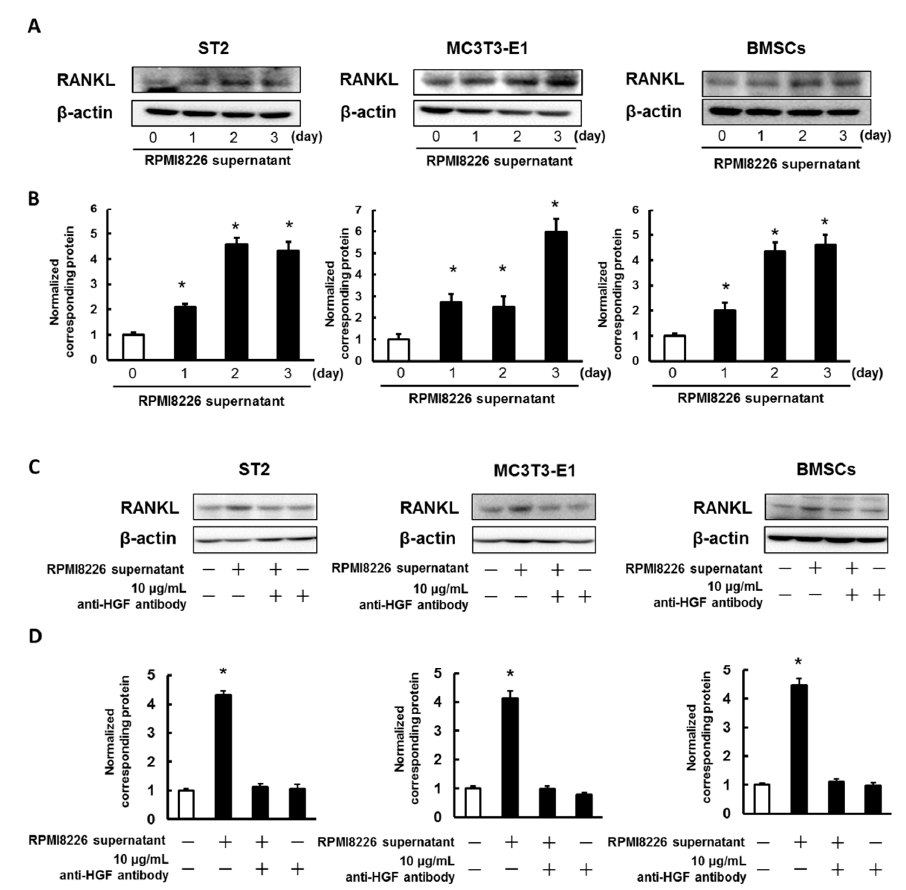
Figure 3. RPMI8226 cell supernatant induces RANKL expression. ( A ) ST2 cells, MC3T3-E1 cells, and mouse BMSCs were incubated with RPMI8226 cell supernatant. At various time points, the cell lysates were analyzed by western blotting using anti-RANKL antibody. ( B ) Quantification of the amount of RANKL, normalized to the amounts of β -actin. The results are representative of five independent experiments. * p < 0.01, compared to controls (one-way ANOVA with Dunnett’s test). ( C ) ST2 cells, MC3T3-E1 cells, and mouse BMSCs were incubated with RPMI8226 cell supernatant and 10 µ g / mL anti-HGF neutralizing antibody (R&D Systems, Minneapolis, Minnesota, USA). After incubation for 72 h, the cell lysates were analyzed through western blot analysis using the anti-RANKL antibody. ( D ) Quantification of the level of RANKL was performed by normalizing it to the β -actin level. The results of five independent experiments are presented here. * p < 0.01, when compared to the controls (one-way ANOVA with Dunnett’s